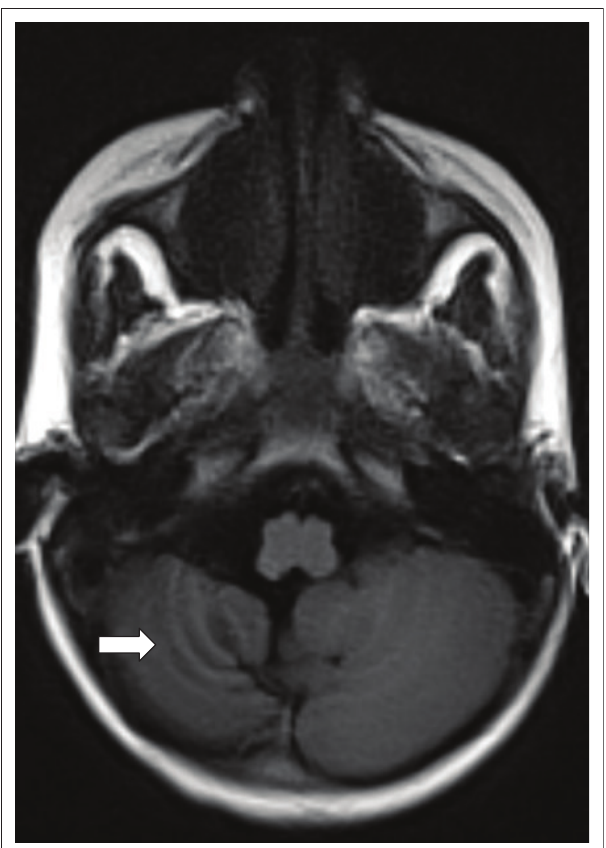
FIGURE 1: Axial T1 sequence showing right cerebellar atrophy with prominence of cerebellar folia (arrow).